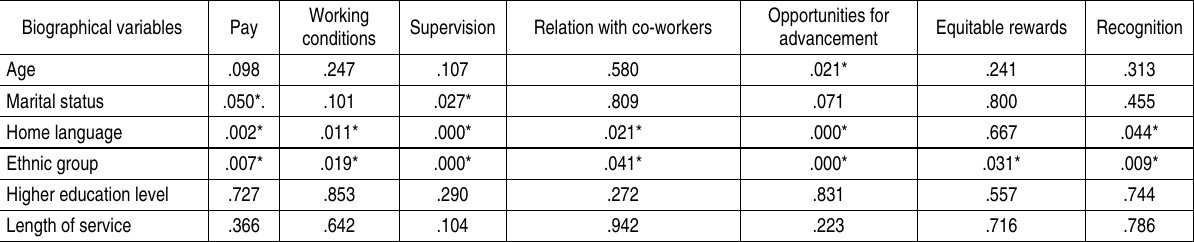
Table 7. ANOVA: biographical variables and job satisfaction